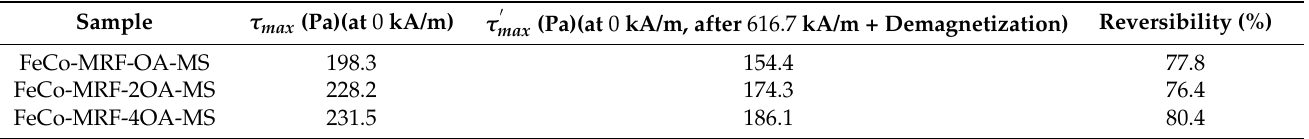
Table 5. Values of the yield stress measured at the maximum shear rate (600 s − 1 ) under different applied magnetic field conditions, for the -MS fabricated fluids with different oleic acid surfactant concentrations studied. Sample